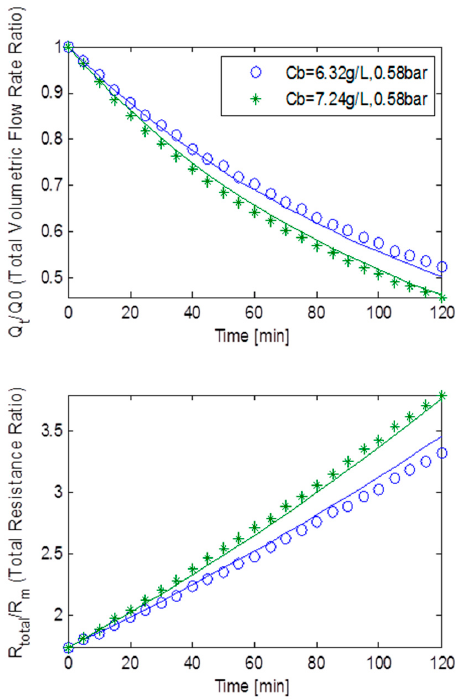
Figure 12. Flux decline and total resistance for TMP step of 58 kPa for the static square-shaped MBR system with best model fits.